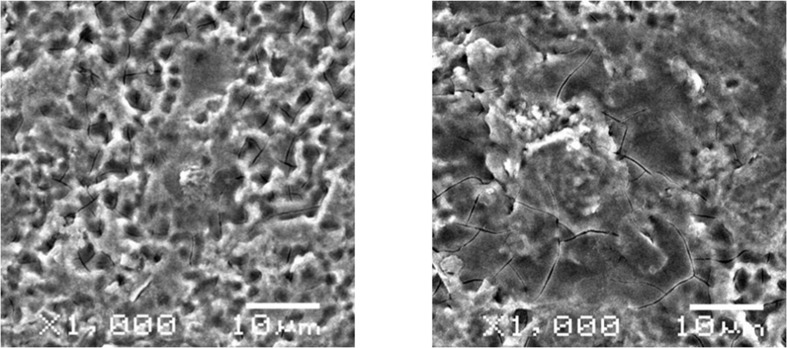
SEM images of internal fixation screws.The surface of nanographene coated screws (right) is covered with a thin layer of laminated material, and the morphology of the surface had clearly not been changed, as shown in the scanning electron microscopy (x1000).